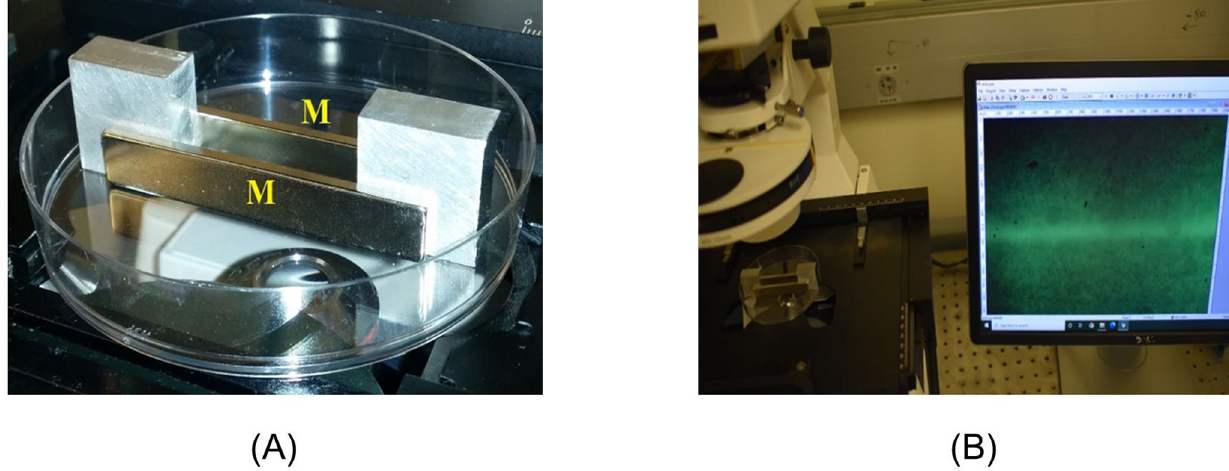
Fig 2. Setup 2 for studying the EZ formation. (A) Two parallel magnets (M), separated by aluminum blocks, placed inside of a petri dish. (B) Microscopic setup for observing EZ formation. The magnets and Petri dishes images are for illustrative purposes only.